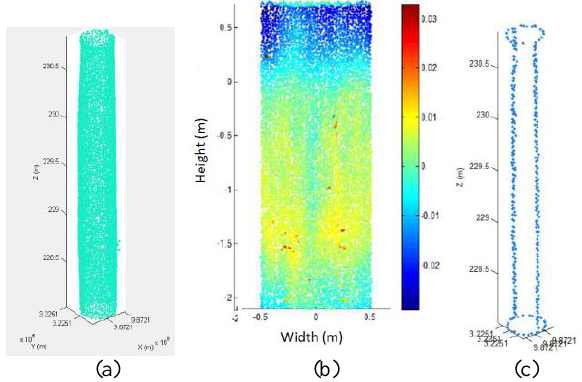
Figure 9. Cylinder development; a) cylinder in general frame; b) translation to the origin of the frame; c) rotation of the cylinder axis; d) expression of the cylinder in cylindrical coordinates.